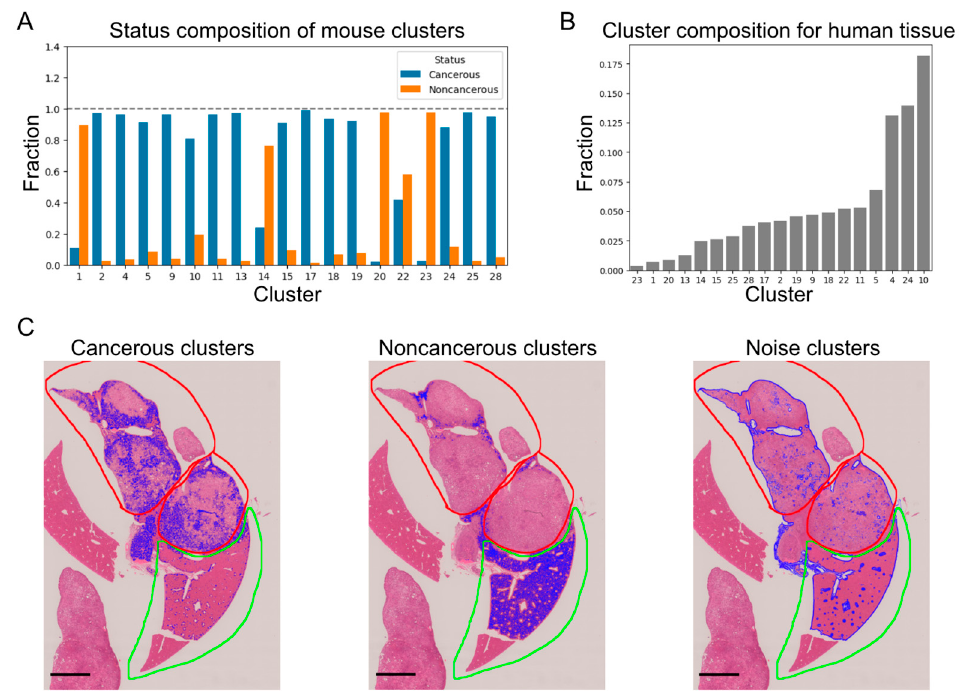
Figure 3. Pixel-level clustering. ( A ) Cancerous/noncancerous composition for clusters in mouse tissue. ( B ) Cluster composition for human tissue microarray specimens. ( C ) Clusters and annotations of mouse tissue. Areas colored blue indicate cancerous, noncancerous, or noise-cluster regions. Red and green contours indicate annotation of cancerous and noncancerous regions, respectively, by a medical expert. Scale bar = 2.0 mm